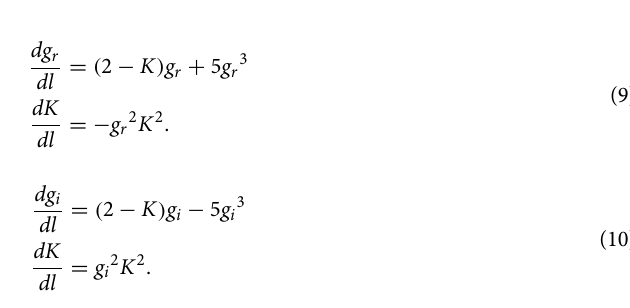
Figure 6 represents results of QBKT study based on four sets of RG equations (Eqs. 7, 8, 9, 10). The upper and lower panels are respectively present results of third-order and second-order RG calculations. Each panel consists of two figures, the left and right figure are respectively for the RG flow study of g r and g i with K . It is found that the left figures of upper and lower panels have three regions, weak coupling region (mark by I in the figure) where the RG flow lines for g r flowing off to the zero, i.e, the system is in the gapless TLL phase, upto 2 . In the strong coupling region (mark by III in the figure), the RG flow lines for the coupling g r flowing K = off to the strong coupling phase and this phase system is in the gapped insulating phase. The other region is the cross over region, in this region system goes from weak coupling phase to the strong coupling phase (mark by II in the figure). The separatrix of different quantum phases are marked by the red colour lines and the fixed line by the magenta colour in the RG flow diagram. It is found that the results of 3rd order RG, the flow lines are much g r 3 ) in the RG flow more stiffer compare to the 2nd order RG due to the presence of an extra term ( ∼